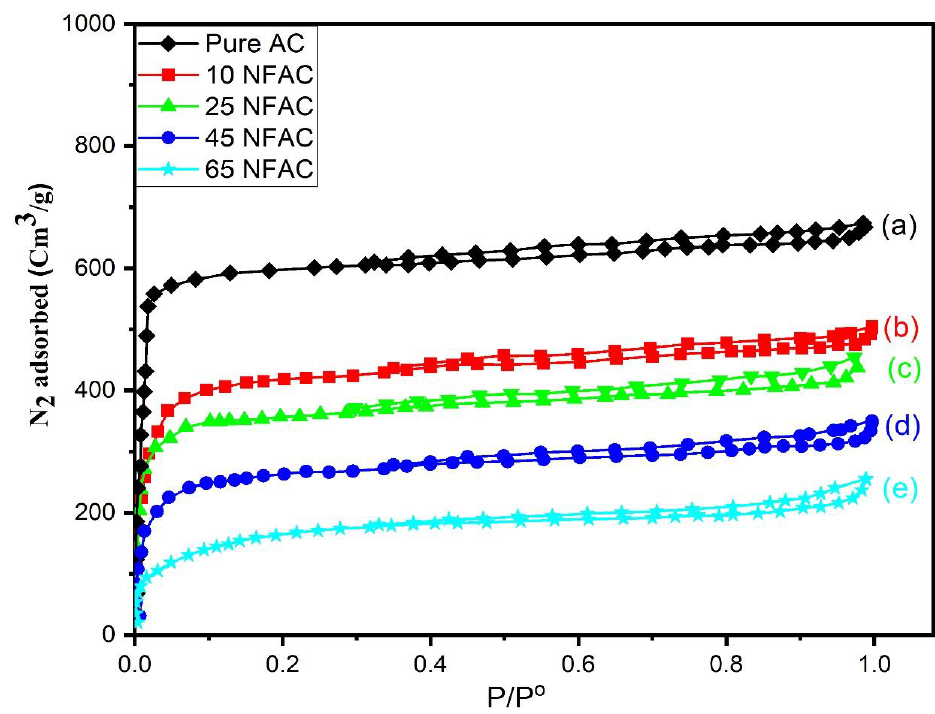
Figure 3. Nitrogen adsorption – desorption isotherms of ( a ) pure AC, ( b ) 10NFAC, ( c ) 25NFAC, ( d ) 45NFAC, and ( e ) 65 NFAC.